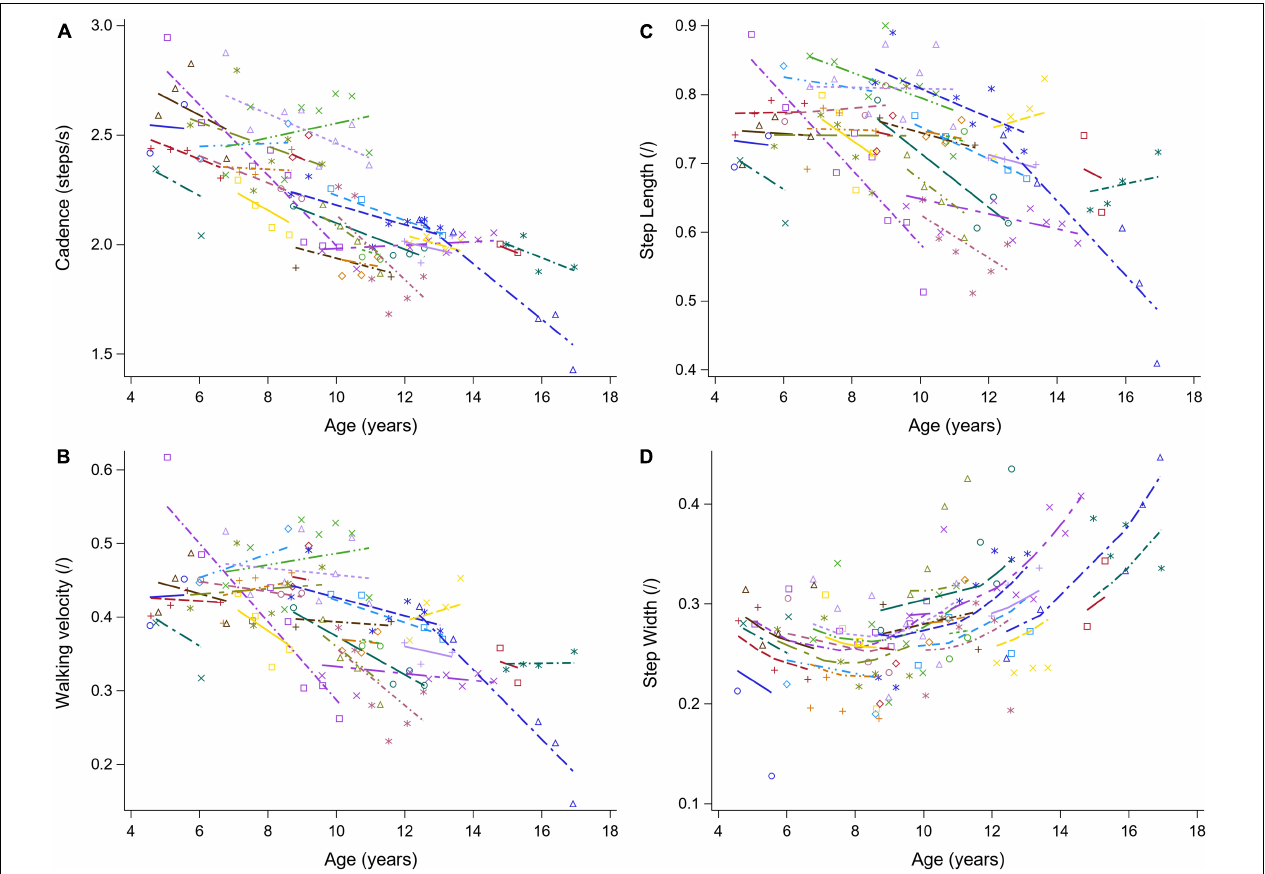
FIGURE 3 | The individual predicted profiles (dashed lines) for cadence (A) , normalized walking velocity (B) , normalized step length (C) , and normalized step width (D) . The actual observed values are visualized by the symbols. Each color represents one patient with DMD. The regression coefficients of the fixed effects are given in Table 3 . DMD, Duchenne muscular